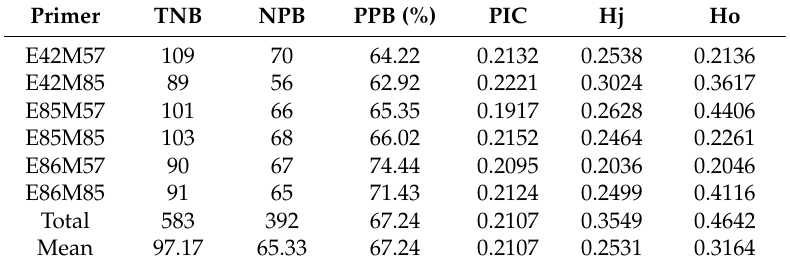
Table 1. Summary of genetic diversity based on AFLP loci amplified by each primer combination.